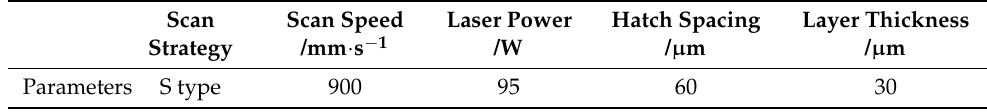
Table 3. Process parameters of 3D printing.